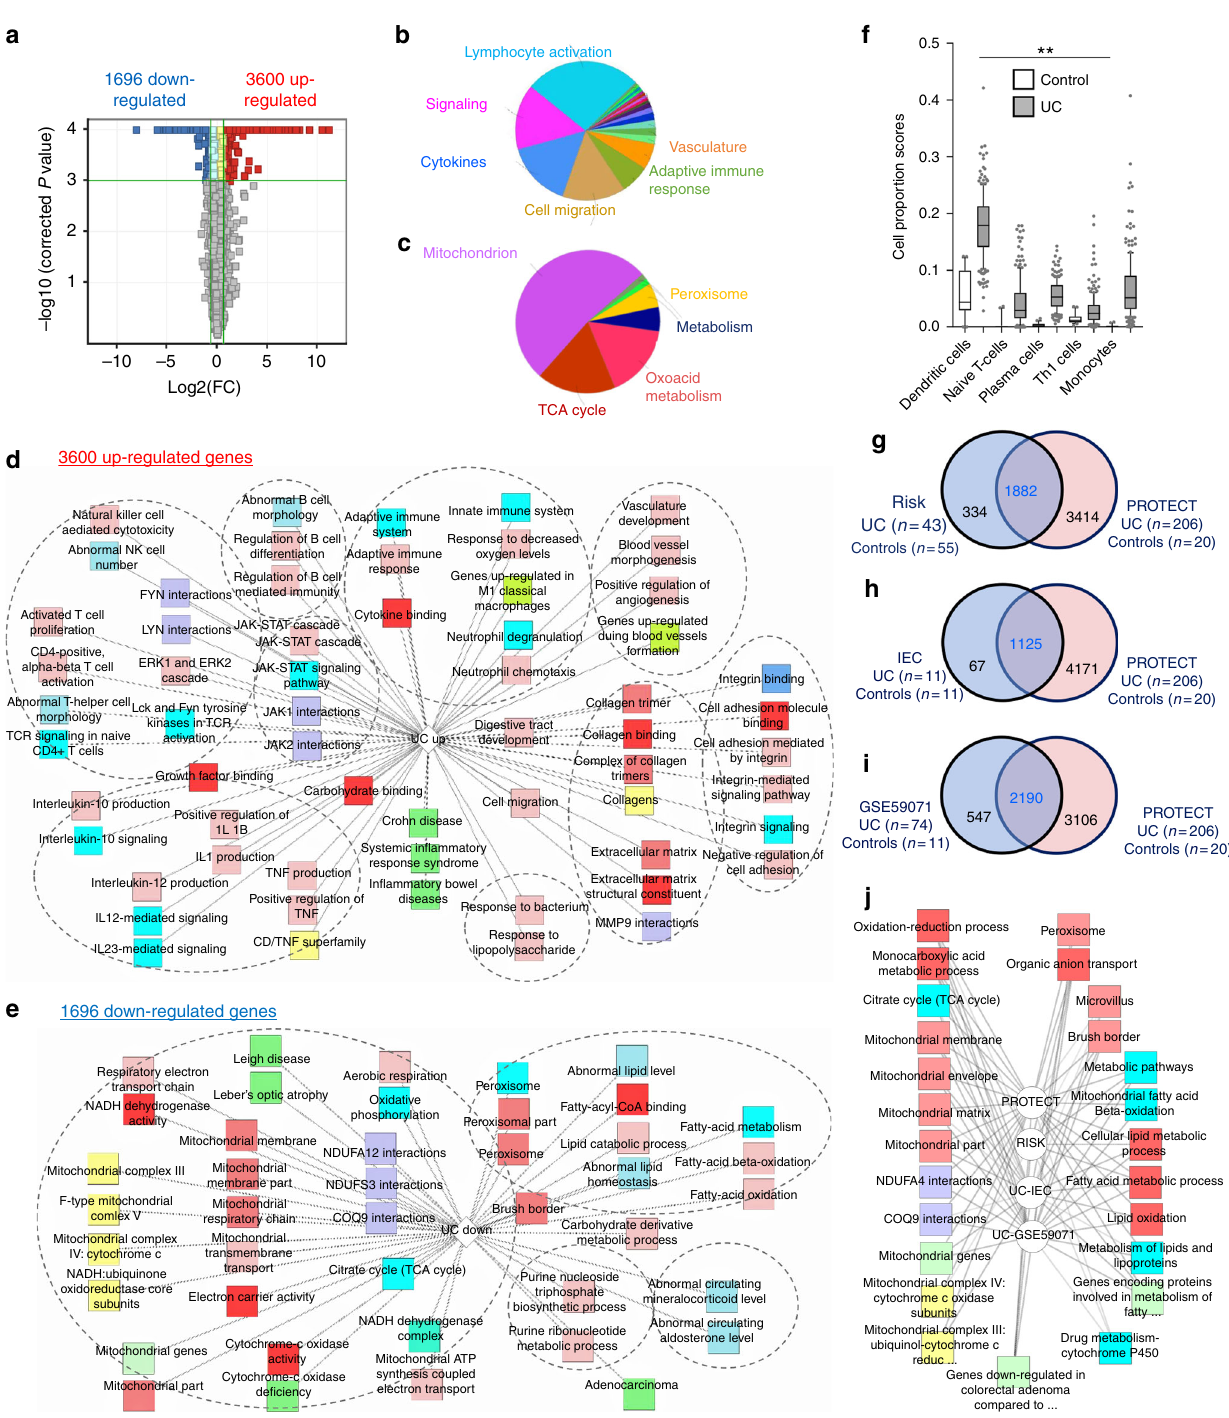
Fig. 1 The core genes and pathways of newly diagnosed treatment-naive pediatric Ulcerative colitis emphasize lymphocyte activation and mitochondrial dysfunction. a Volcano plot of the 5296 differentially expressed genes between 206 UC and 20 Ctl samples (FC ≥ 1.5 and FDR < 0.001). Functional annotation enrichment analyses of the b 3600 upregulated and c 1696 downregulated UC core genes using CluGO 8 charts. Detailed functional annotation enrichment analyses of the d 3600 upregulated and e 1696 downregulated UC core genes using ToppGene 6 , ToppCluster 7 , and Cytoscape 52 are shown. GO Biological Process, Cellular Component, and Molecular Function (pink), pathways (light blue), mouse phenotype (blue), gene family (yellow), coexpression (light green), disease (dark green), interactions (purple). The full list of gene set enrichment results and P values are in Supplementary Dataset 1. f Computational deconvolution of cell subset proportions in 206 UC and 20 controls. Differences (Wilcoxon test with FDR < 0.01 (**)) are shown for cell types with at least 80% non-zero values. Overlap of differentially expressed genes between UC and Ctl in g RISK, h isolated colon epithelial cells (IEC 13 ), and i a microarray study of adult cases (GSE59071 12 ). j Detailed functional annotation enrichment analyses of the shared downregulated functions of the above studies. Box and whisker plot with central line indicating median, box ends representing upper and lower quartile, and whisker represent 10 – 90 percentile. UC ulcerative colitis